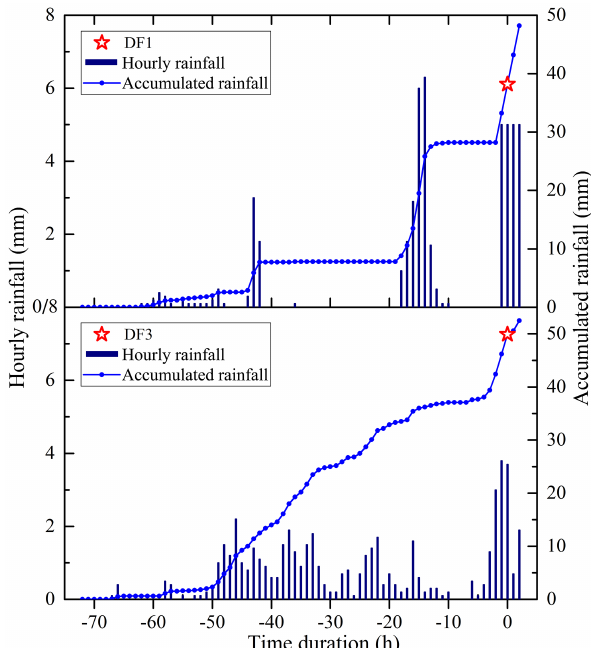
Figure 9. Variations in rainfall accumulation prior to DF1 and DF3 (no rainfall before